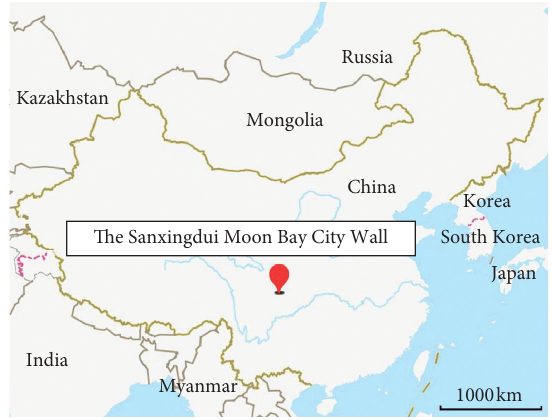
Figure 1: The location map of the Sanxingdui Moon Bay City